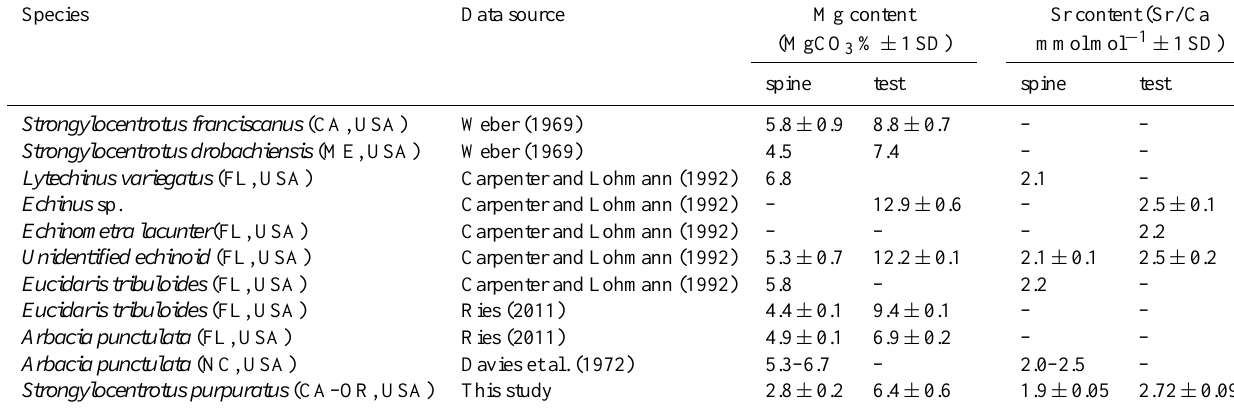
Table 3. Magnesium and strontium content of adult S. purpuratus ossicles compared with other sea urchin taxa. Species